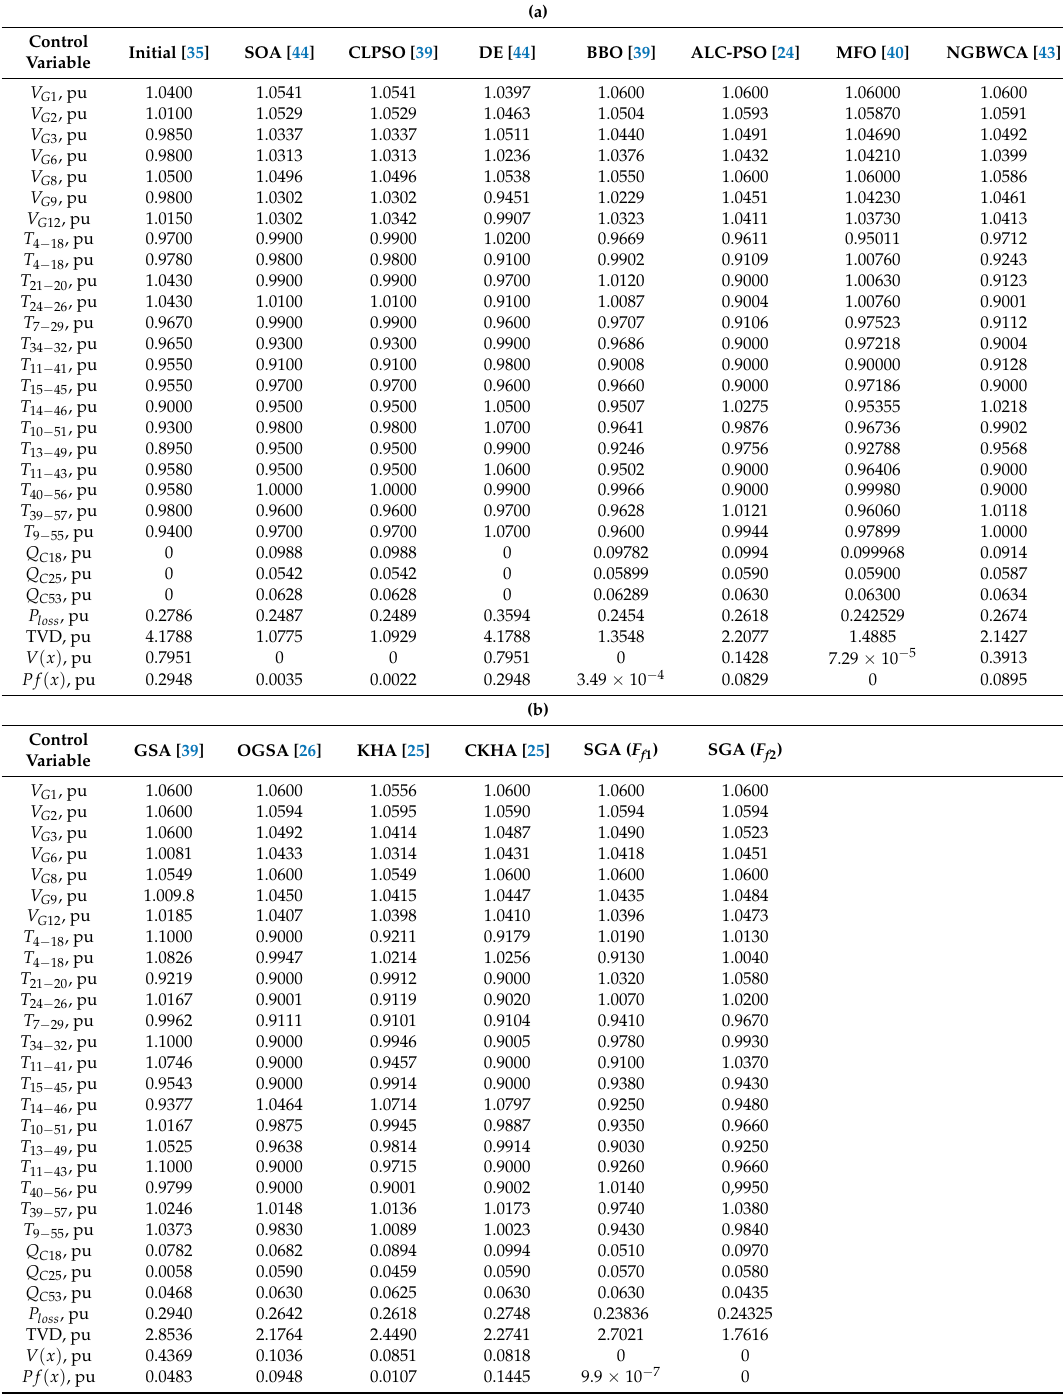
Table 6. Best control variable settings for power loss minimization of IEEE 57 bus test system with different